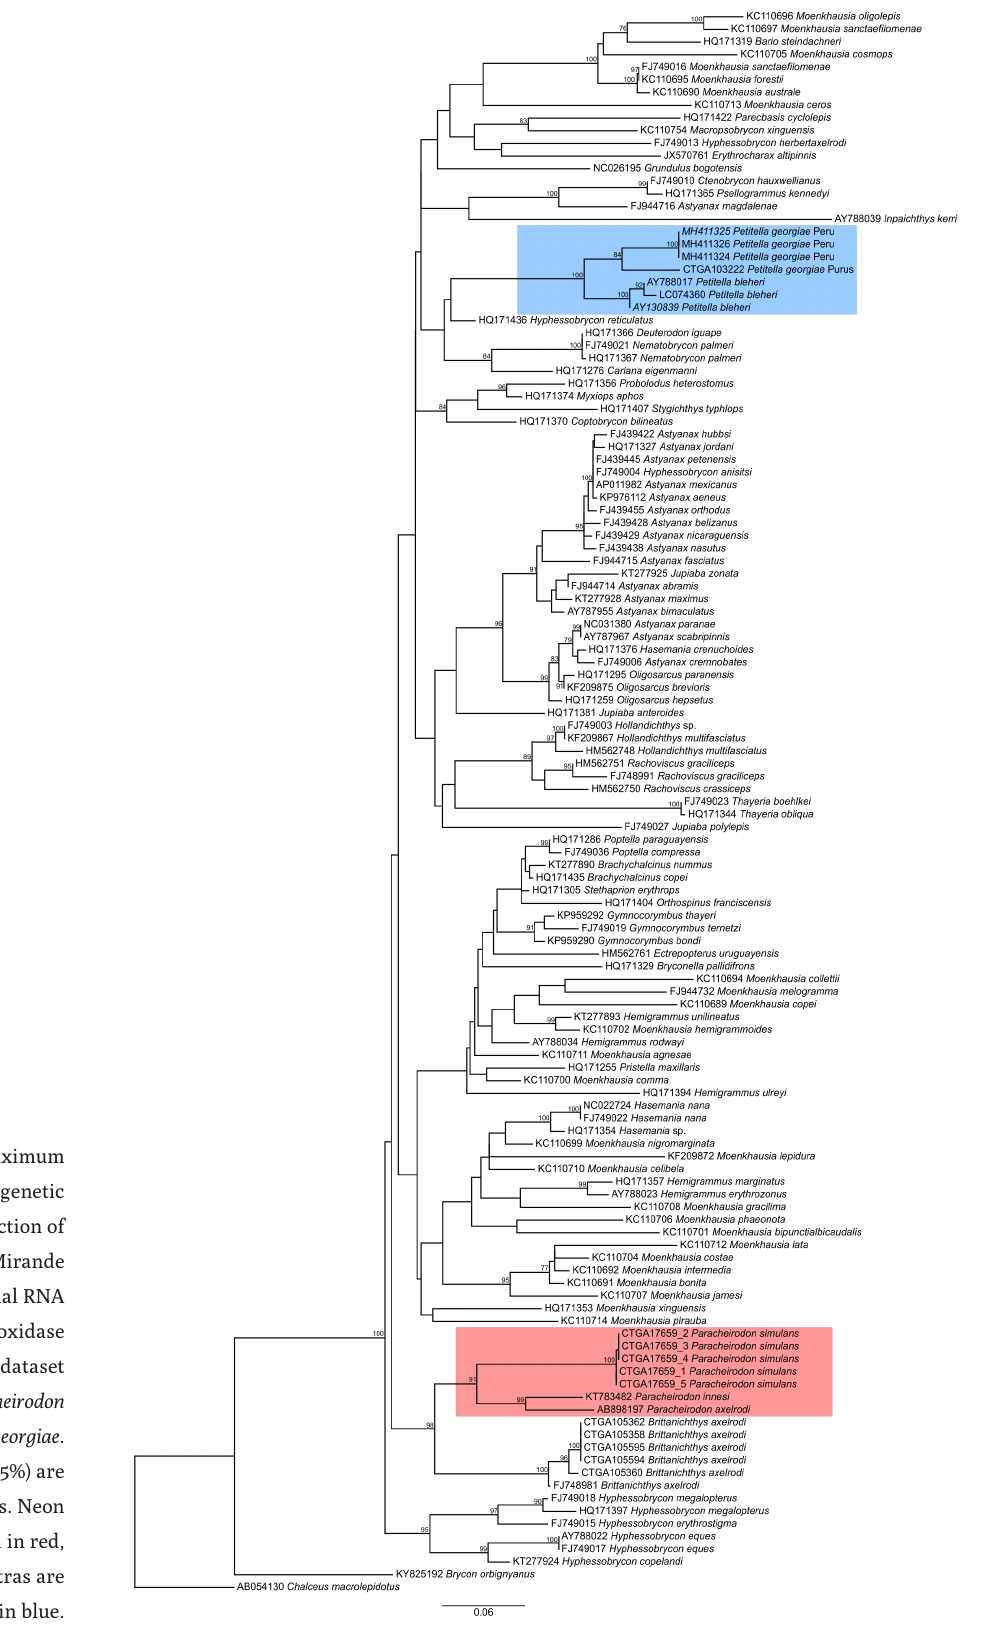
FIGURE 1 | Maximum Likelihood phylogenetic reconstruction of Stethaprioninae sensu Mirande (2018) using 16S ribosomal RNA and cytochrome C oxidase subunit I concatenated dataset after inclusion of Paracheirodon simulans and Petitella georgiae . Bootstrap values (≥ 75%) are shown near the nodes. Neon tetras are highlighted in red, and rummy-nose tetras are highlighted in